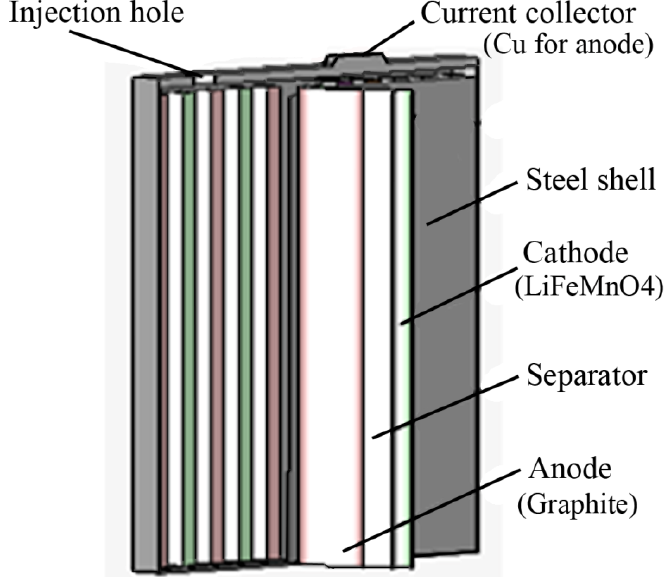
Figure 4. Schematic diagram of the internal cell structure of the batteries used in the experiments. As the battery is symmetrical, the figure only shows half of the